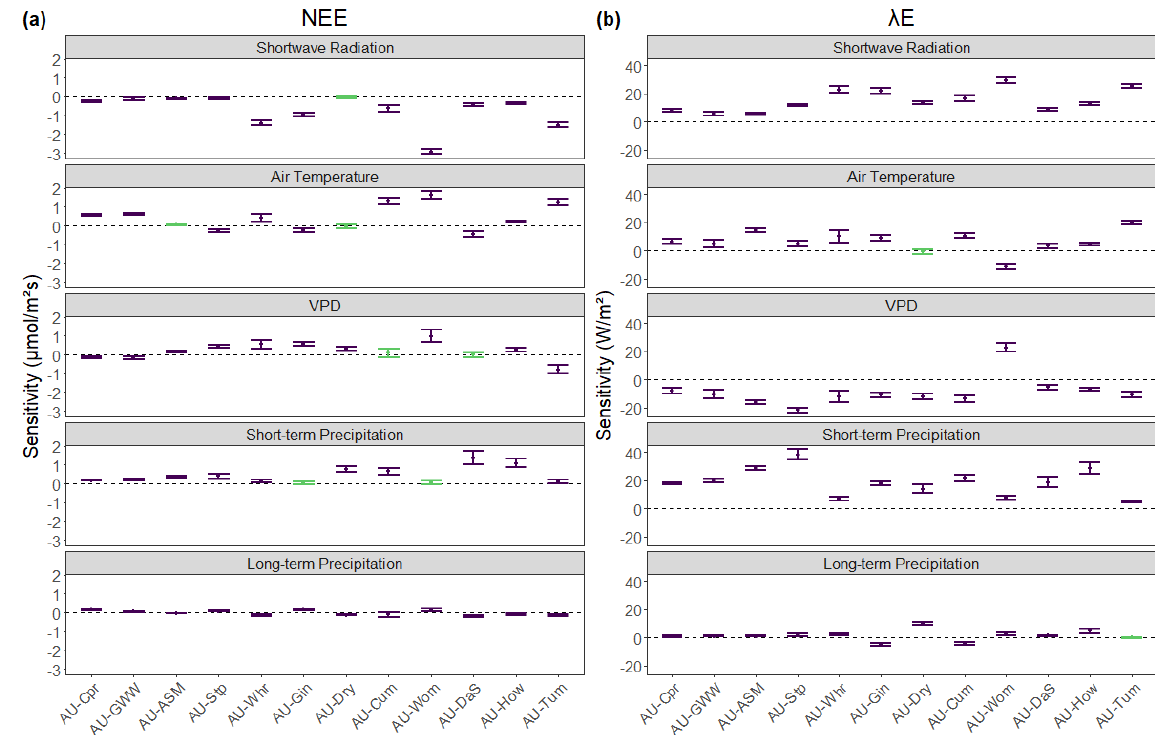
Figure 2. Sensitivity of the flux to each climate variable for (a) NEE and (b) λE in the environmental memory models. Sites are on the x axis, ordered by ascending mean annual precipitation. The y axis is the sum of all G n and D n coefficients from Eq. (1), where n includes the climate variable, divided by the mean standard deviation of the corresponding weighted sums from Table 2, such that sensitivity values are comparable between variables. Where the range of sensitivity includes 0, those variables are considered to non-significantly affect the flux and are coloured green in the